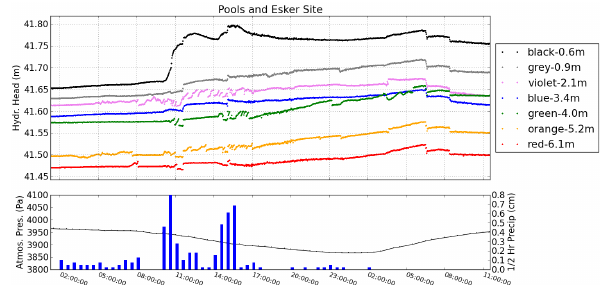
Fig. 8. Pressure transducer data during the initial atmospheric pres- sure drop during Tropical Storm Irene on 28 August 2011. Fluctua- tions in pressure data believed to be gas release occur in all loggers. A downward gradient in hydraulic head towards the esker is also evident.